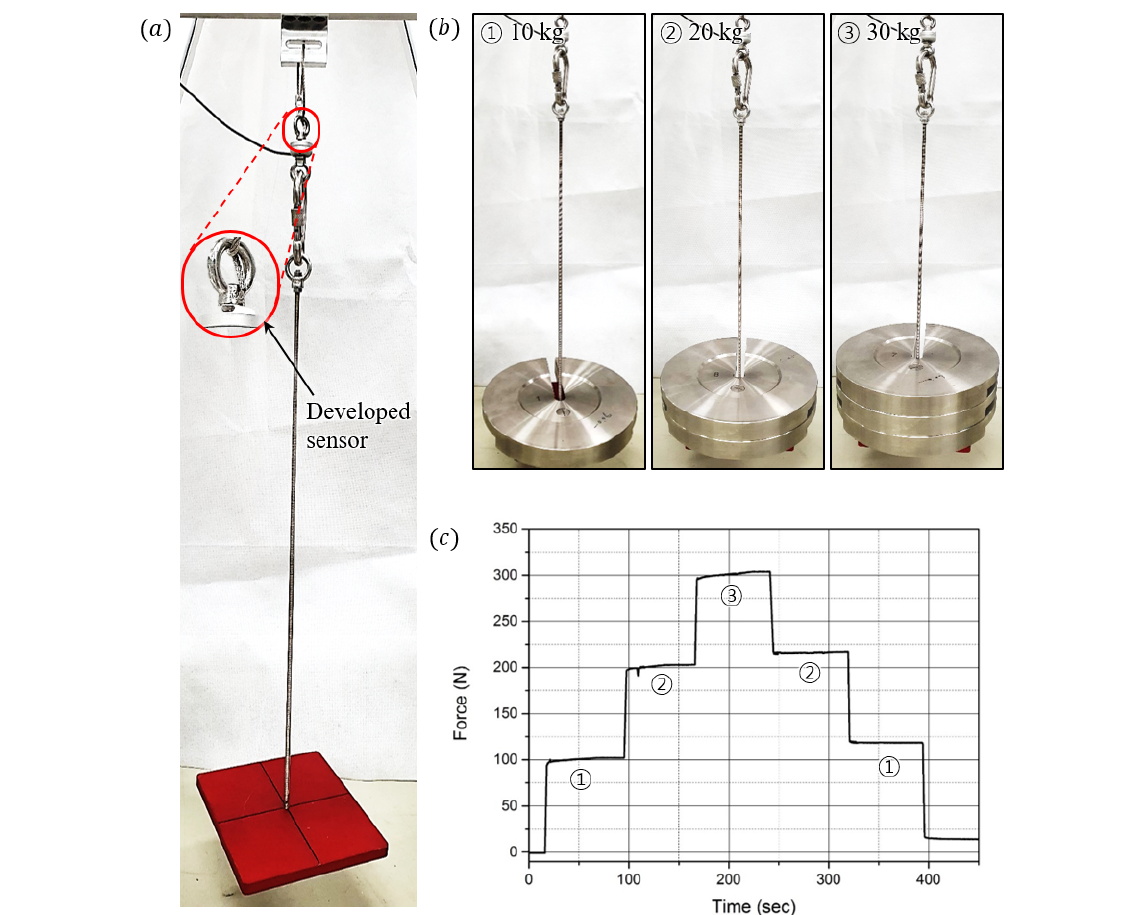
Figure 14. Experiment to evaluate high-load capacity. ( a ) Configuration of the experimental setup. ( b ) Experimental scene when loading mass disks of 10 kg, 20 kg, and 30 kg. ( c ) Result of the high-load capacity